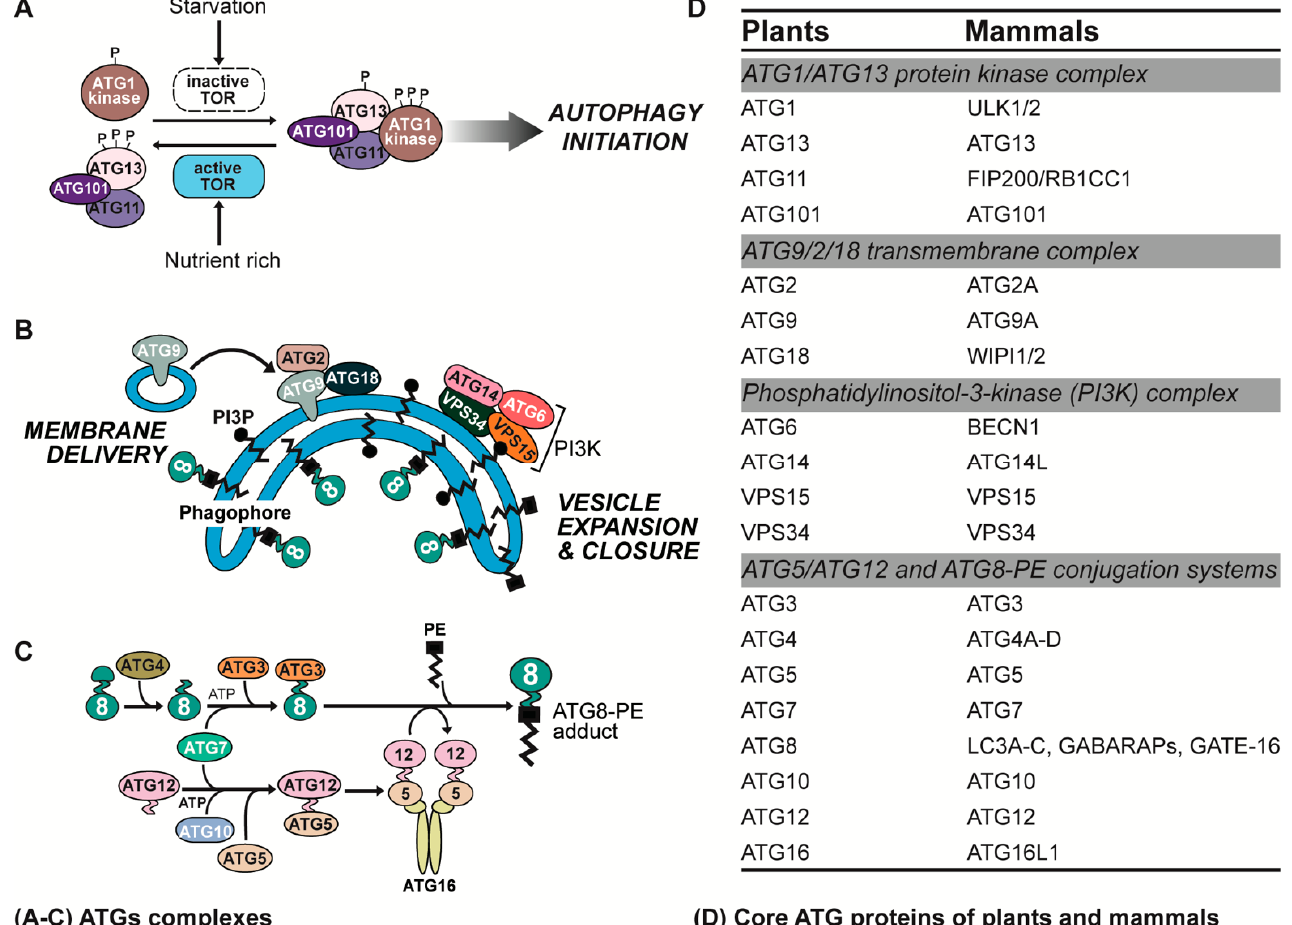
Figure 2. Core protein complexes of autophagy in plants and animals. ( A ) The ATG1/ATG13 protein kinase complex. When plants are under nutrient ‐ rich conditions, TOR kinase hyperphosphorylates ATG13. While plants are placed in nutrient starved conditions, the TOR kinase is inactivated, resulting in the dephosphorylation of ATG13, which binds tightly to ATG1. Then, the ATG1 kinase activity is activated and autophosphorylation occurs to form the ATG1, ATG11, ATG13, and ATG101 complex, which results in upregulating autophagy. ( B ) The ATG9/2/18 transmembrane complex and PI3K complex. ATG9 delivers membrane source and mediates the extension of phag ‐ ophore membrane. ATG2 and ATG18 play a synergistic role in this process. The PI3K protein com ‐ plex promotes the nucleation of vesicles, which include ATG6, ATG14, VPS34, VPS15, and PI3P. ( C ) The ATG5 ‐ ATG12 and ATG8 ‐ PE ubiquitin ‐ like conjugating systems. ATG12 was transferred to the target protein ATG5 with the help of ATG7 and ATG10. Subsequently, the ATG5 ‐ ATG12 complex combines with ATG16 to form an oligomeric complex, which participated in the esterification of ATG8. During the covalent binding stage of ATG8 ‐ PE, the cysteine protease ATG4 cleaves the C ‐ terminus of ATG8. Subsequently, ATG8 is activated by ATG7 and transferred to ATG3 through a thioester bond. At last, with the help of ATG5 ‐ ATG12 ‐ ATG16 conjugate, ATG8 forms an ATG8 ‐ PE adduct with phosphatidylethanolamine. ( D ) Core ATG proteins of plants and mammals in four complexes.